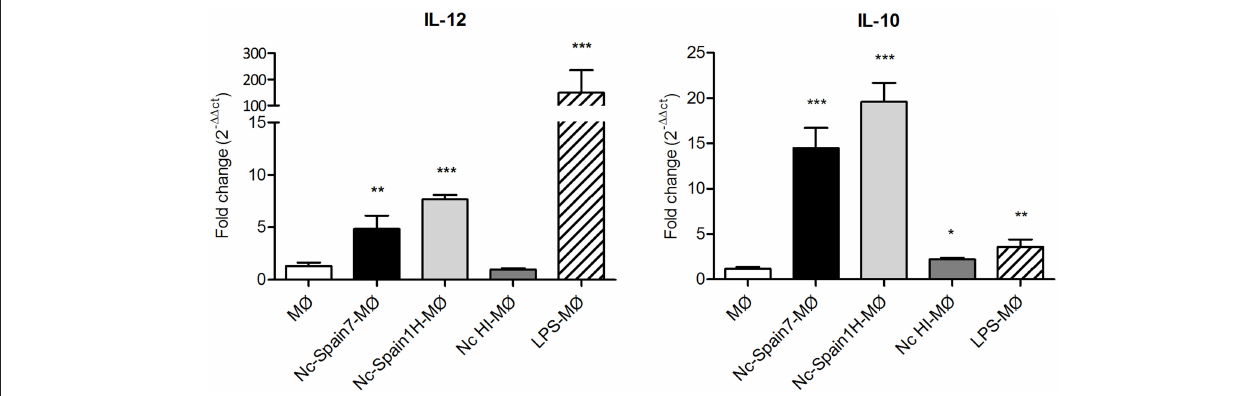
FIGURE 7 | Cytokine mRNA expression in bovine MØs infected with N. caninum . Graphs represent the relative quantification of IL-10 and IL-12p40 mRNA expression levels (x-fold change in expression) in MØs challenged for 8h with N. caninum Nc-Spain7 (Nc-Spain7-MØ), Nc-Spain1H (Nc-Spain1H-MØ), heat-inactivated